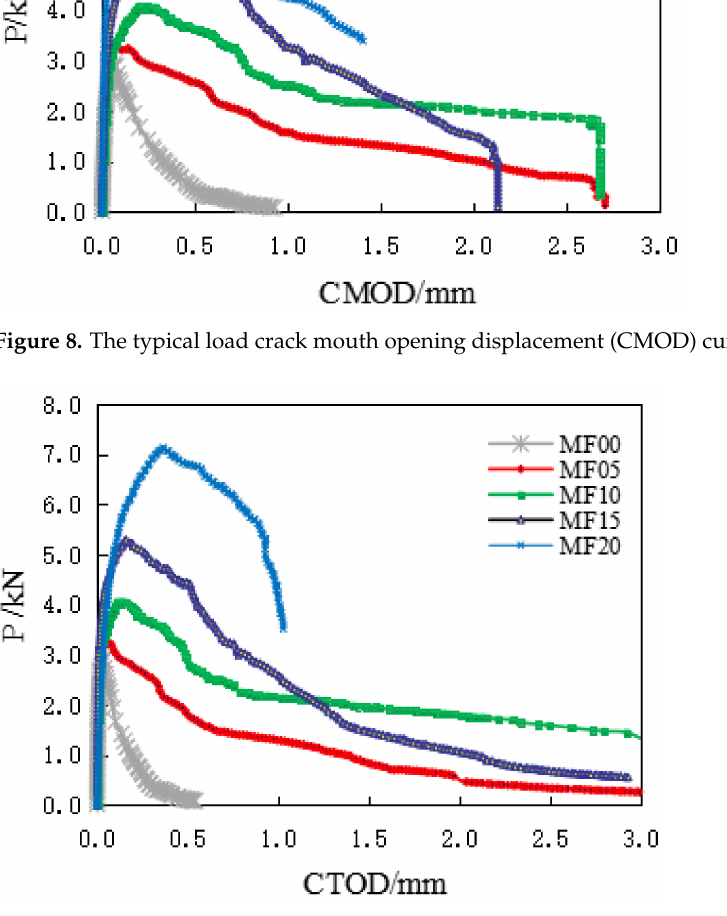
Figure 9. The typical load crack tip opening displacement (CTOD)